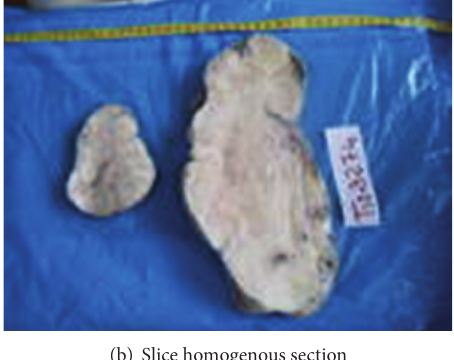
Figure 4: Histology of both surgical specimens in favor of ovar- ian